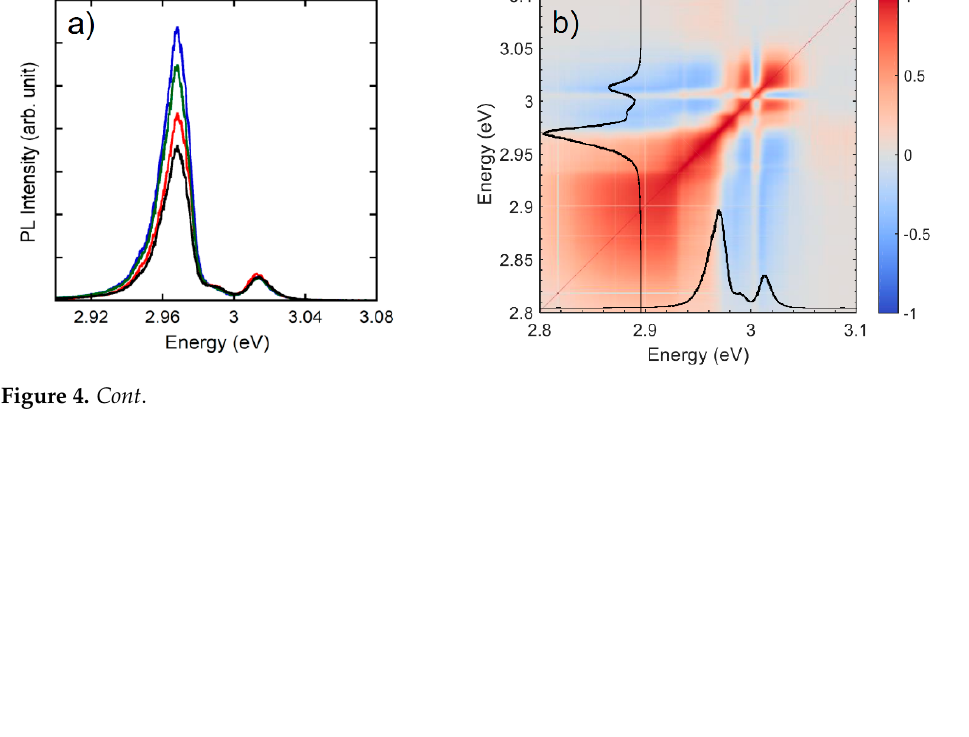
Figure 4. ( a ) Micro-PL spectra at 10 K for sample A acquired in different sample spots spanning a 25 × 25 µm 2 area. ( b ) Pearson correlation map in the same sample area. The black lines correspond to the spatially integrated PL spectra in the same sample area. ( c , d ) PL intensity for P α and P β , respectively, in the same sample area. 3.2.2. Time-Resolved Photoluminescence In order to clarify the nature of the recombination of α and β -band, we performed TR spectra at different temperatures (from 10 to 280 K) after picosecond excitation at 3.45 eV with an intensity of 10 W/cm 2 , corresponding to a photon flux of ~4 × 10 11 photons/cm 2 . Results at 14 K are reported in Figure 5. A typical streak camera image is shown in Figure 5a, from which TR spectra and decays are extracted (Figure 5b–d). The TR spectra at different delay times are shown in Figure 5b on a log scale: all spectra, at each time delay, exhibit an exponential thermal tail whose effective time dependent temperature can be evaluated assuming the Boltzmann distribution for the carriers [31,32]. In this case the initial carrier temperature around 140 K progressively decreases down to 80 K (see Figure S5), maintaining a value higher than the lattice temperature for a long time, as already observed in CsPbBr 3 [32]. After a fast rise the population thermalizes and, as a consequence, all the states around P α (in the range 2.960–2.990 eV) decay with the same time constant. Instead, a strong difference of the PL lifetime is observed at P α and P β (Figure 5d), and the TR spectra of Figure 5b indicate a substantial independence of the two bands recombination with a lack of population transfer between β and α bands, con- firming the absence of correlation of the two (Figure 4b).